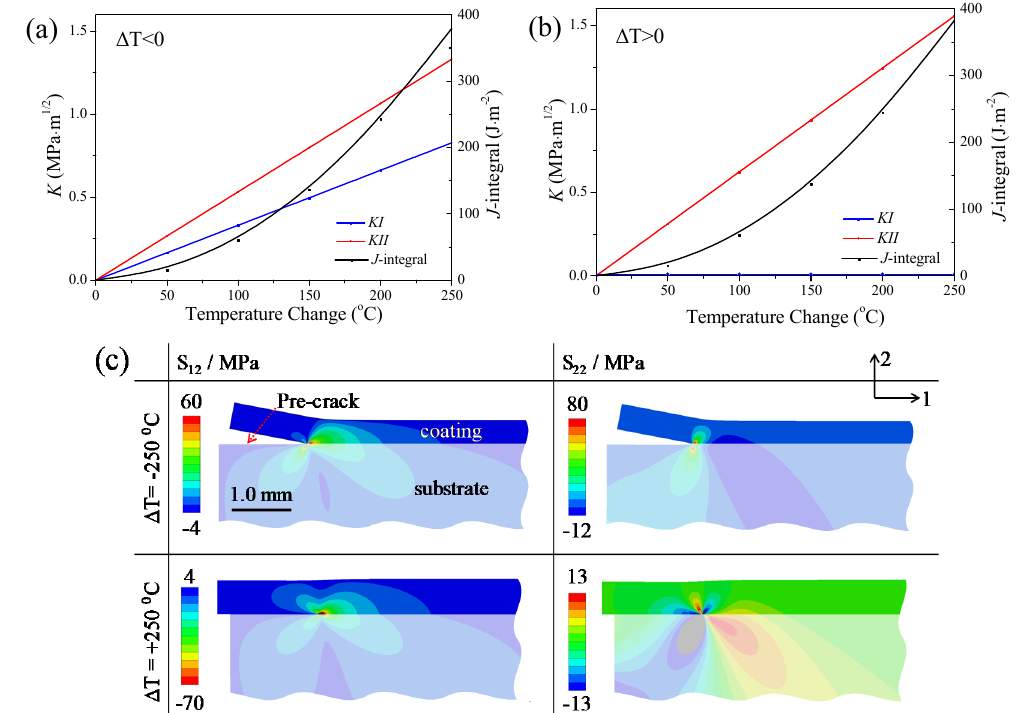
Figure 5. Effect of temperature changes on interfacial K and J i values when the pure epoxy coating system is subjected to ( a ) ∆ T < 0 and ( b ) ∆ T > 0. ( c ) Residual stresses near the crack tip after rapid cooling or rapid heating. The displacements are magnified 5 times in the deformed model.